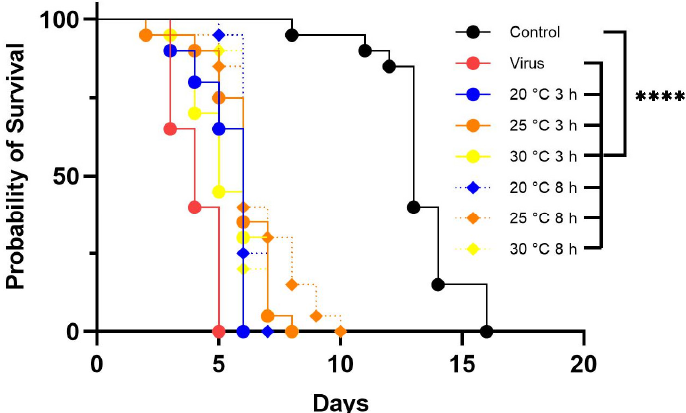
Figure 7. Survival assay following the oral delivery of LJV pre-treated at different temperatures. LJV high concentration (HC, 10 6 GE/mL) was used. LJV was incubated at 20, 25, or 30 °C for 3 h (solid lines) or 8 h (dashed lines). Statistical analysis (Kaplan–Meier) indicated a significant difference (**** p < 0.0001) between the negative control and all flies exposed to LJV.